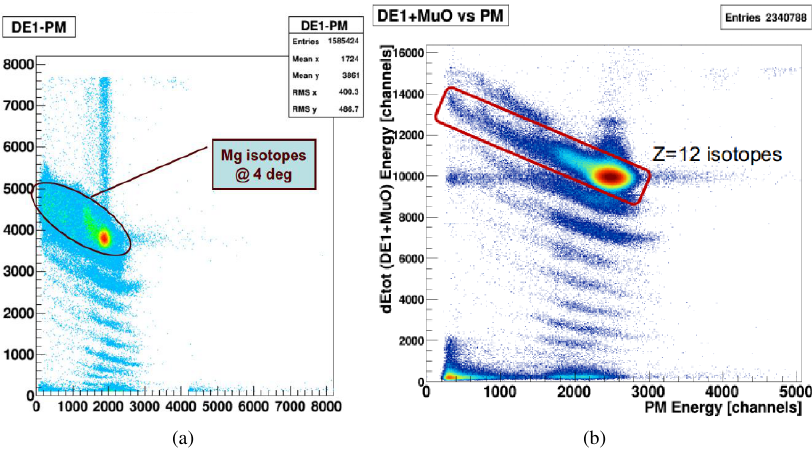
Figure 1: Particle identification plots showing energy loss on Y-axis in channels versus resid- ual energy on X-axis in channels.(a) The data was obtained with the pre-upgrade Oxford detector (b) The data was obtained with the post-upgrade Oxford